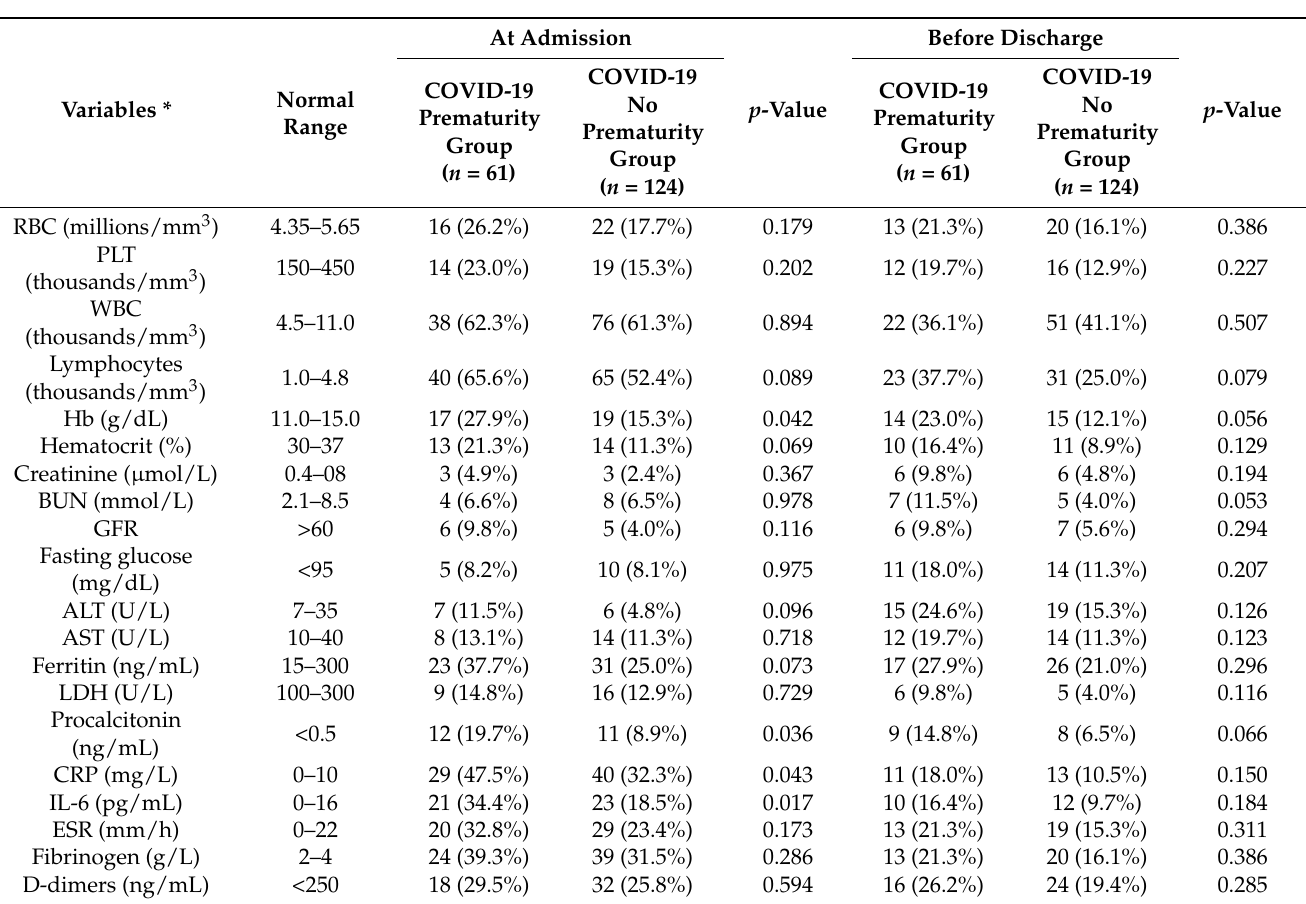
Table 4. Laboratory analysis of pregnant women at admission and discharge for SARS-CoV-2 infection.